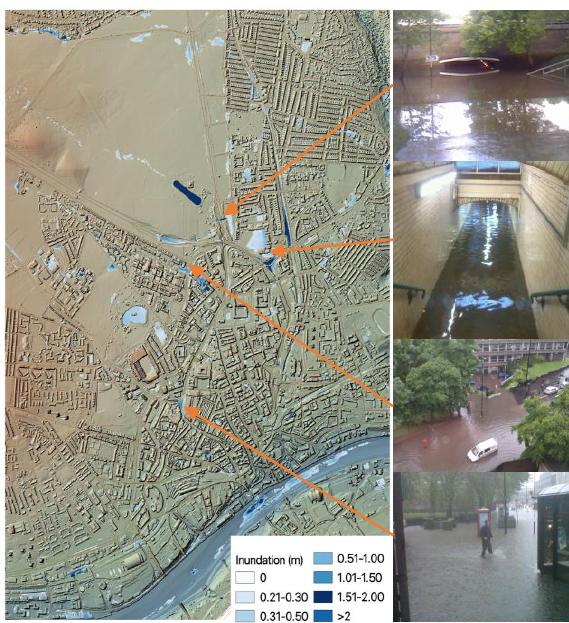
Figure 1. Example output of the HiPIMS surface water flood model for a convective rainfall event of 53mm over the city of Newcastle upon Tyne UK.